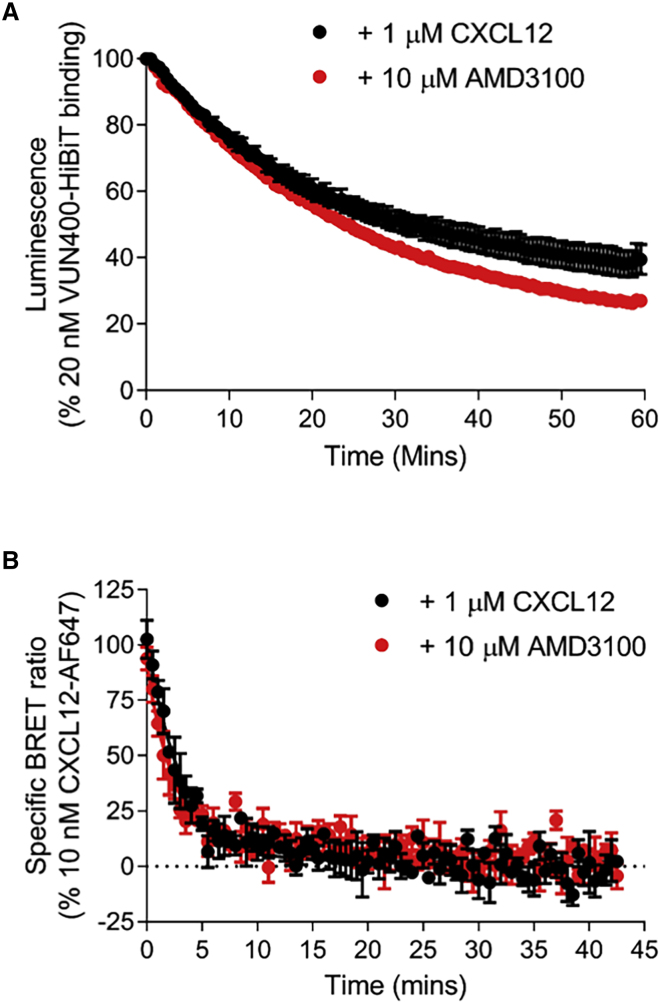
Dissociation Kinetics of Probe-Receptor Complex at LgBiT-CXCR4(A) Decrease in VUN400-HiBiT-LgBiT-CXCR4 complemented luminescence over time following addition of 1 μM CXCL12 or 10 μM AMD3100.(B) Decrease in specific bioluminescence energy transfer ratio from 10 nM CXCL12-AF647 following the addition of 1 μM CXCL12 or 10 μM AMD3100.In these experiments, 20 nM purified HiBiT was added to complement with LgBiT-CXCR4 prior to the addition of ligands. Data are combined mean ± SEM from five (A, CXCL12) or four (A, AMD3100; B) separate experiments, where each experiment was performed in triplicate.